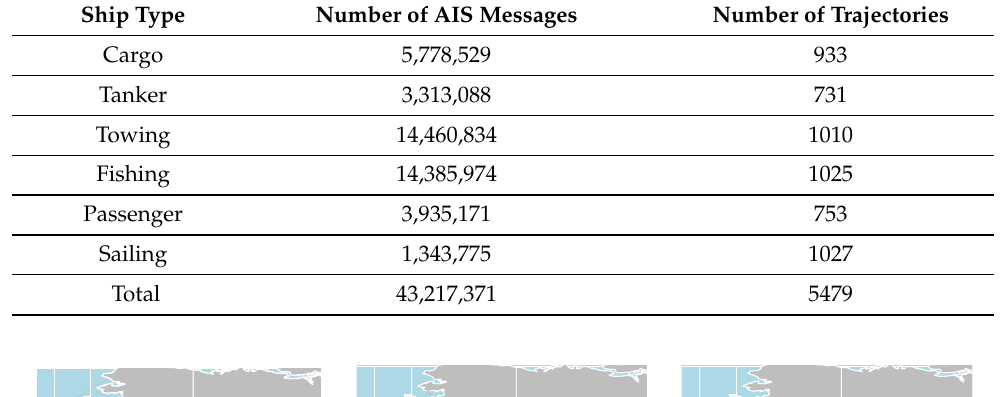
Table 1. A breakdown of the number of AIS messages and the number of trajectories according to class.